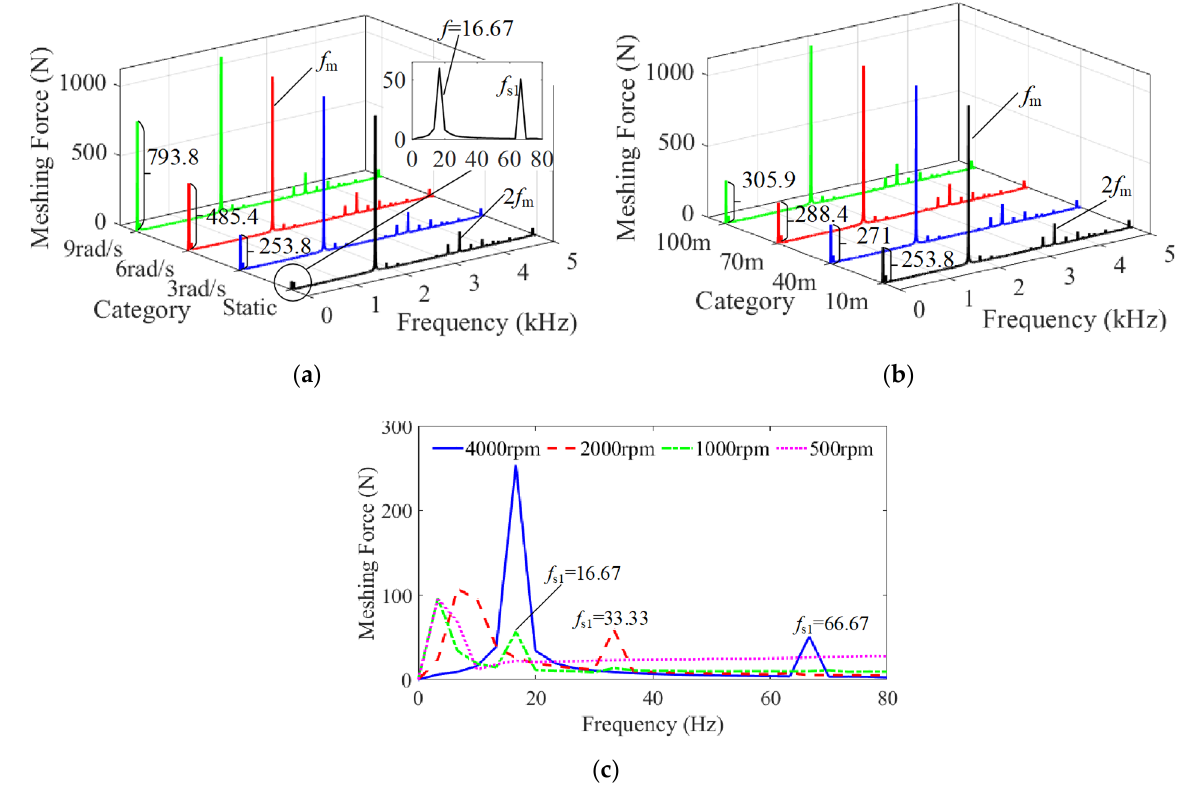
Figure 13. Frequency spectra of the dynamic meshing force of sun-planet1. ( a ) At different LAV; ( b ) At different LR; ( c ) At different input speeds of sun gear. Table 5. Excitation frequency.